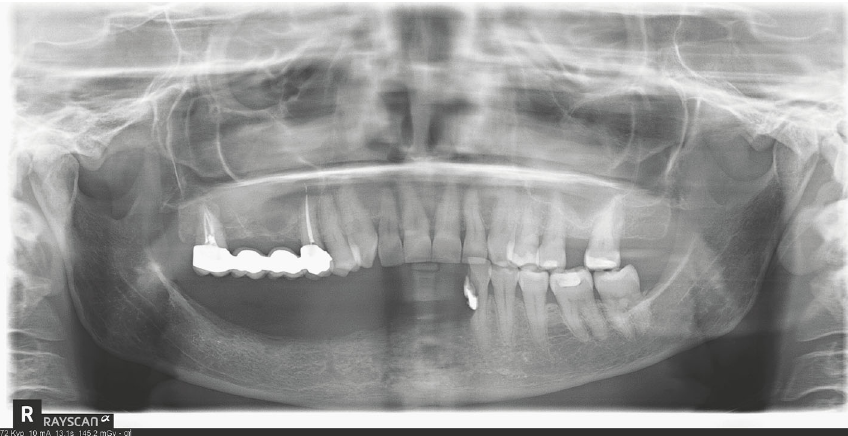
Figure 6: MELISA con fi rmed titanium hypersensitivity: implants were removed.